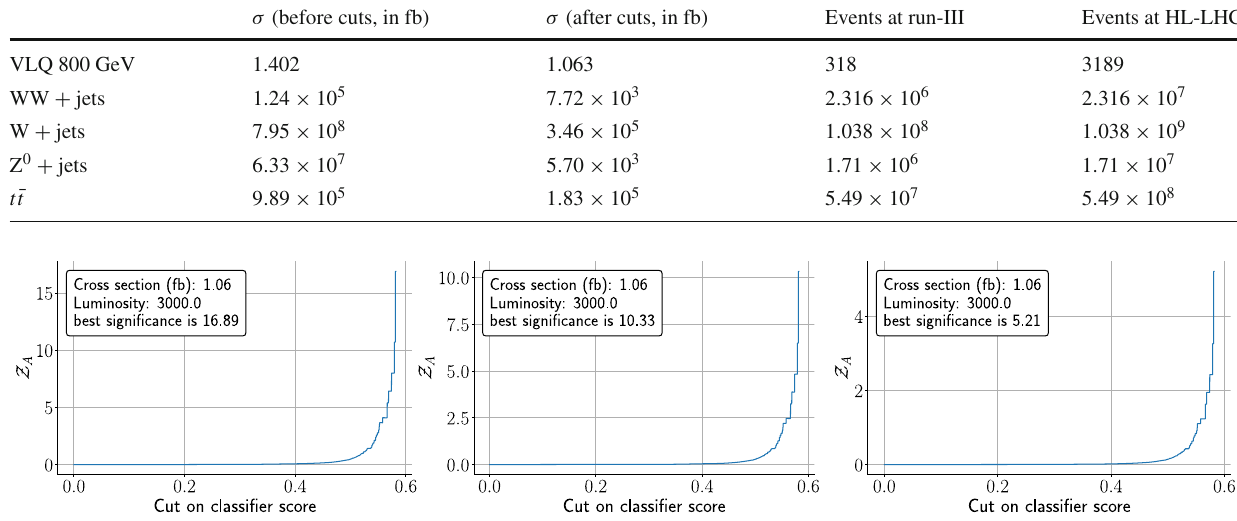
Table 2 Predicted total cross section (in fb) for both the signal and each respective background, before and after the cut selection. In the last two columns we indicate the overall number of expected events for the analysis, calculated as N = σ L , for run-III and the HL phase of the LHC σ (before cuts, in fb) σ (after cuts, in fb)